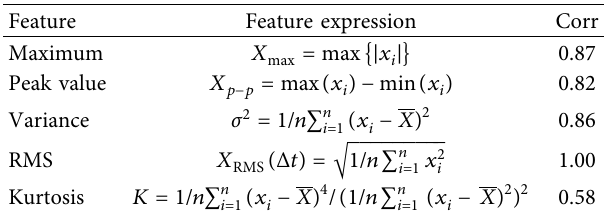
Figure 2: Te 3 groups of data are collected. (a) Te a1 original signal. (b) Te a2 original signal. (c) Te a3 original signal. Table 1: Time domain characteristic indexes and correlation